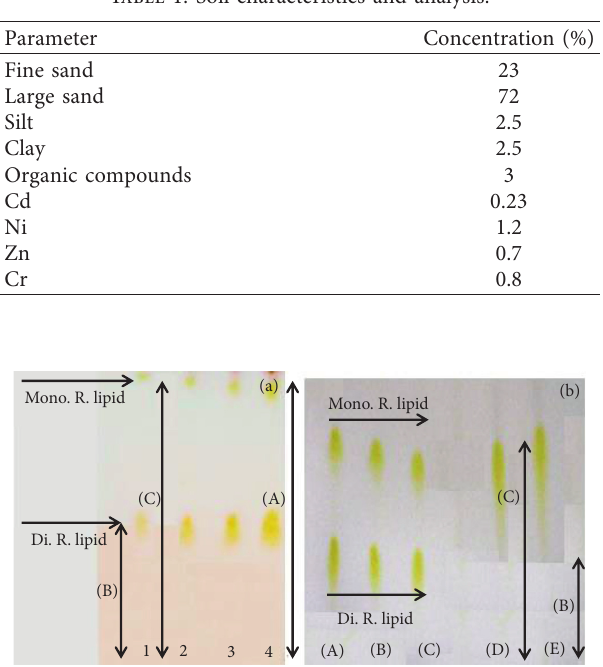
Figure 2: TLC of the mono- and dirhamnolipid: (a) produced; (b) reported in research studies. Table 2: Retention factor of produced rhamnolipid. R f values